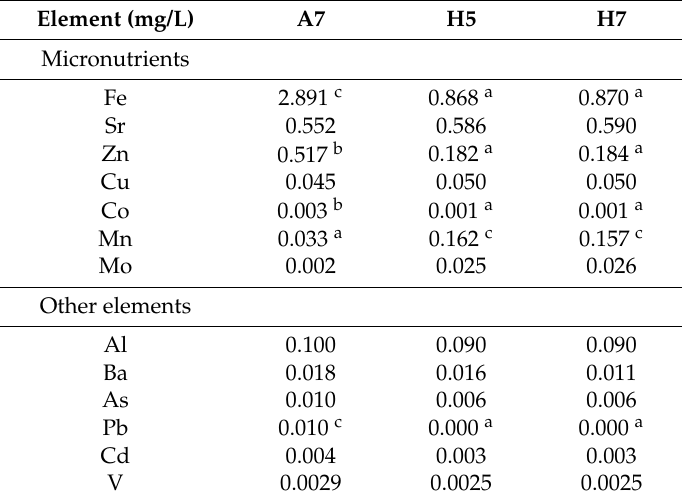
y = 0.0148x + 27.738 R² = 0.9224